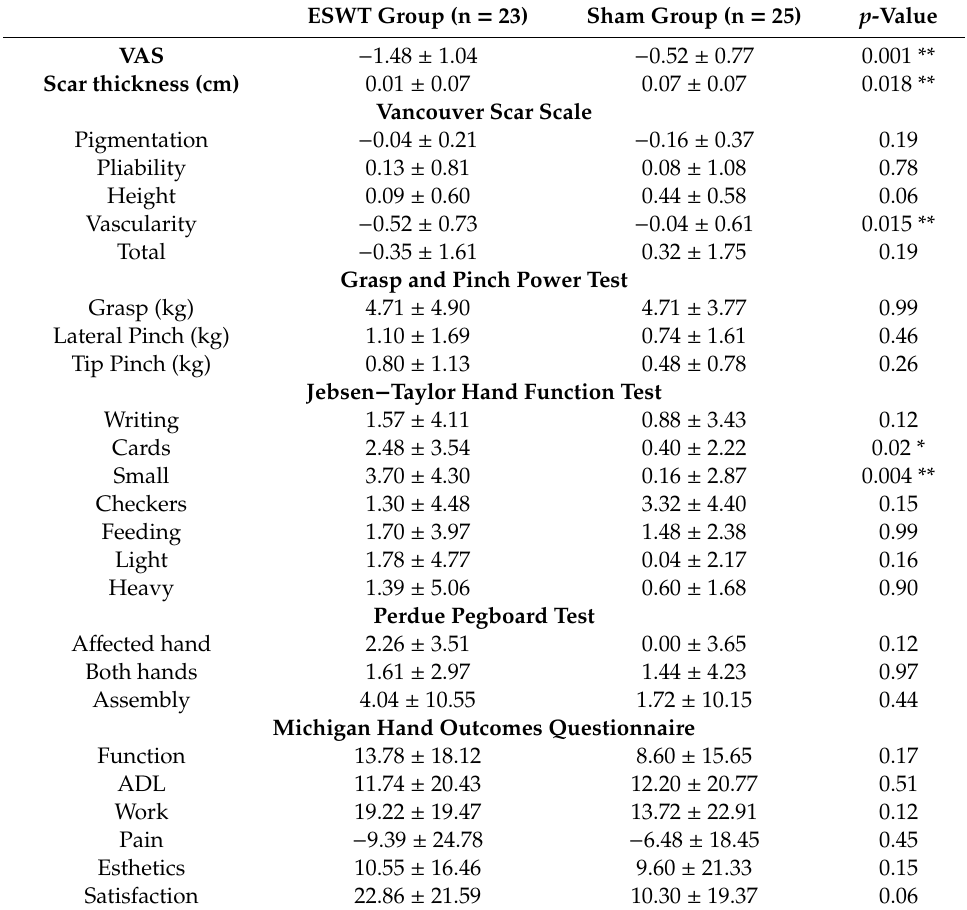
Table 3. Change score (pre- to post-treatment) on measured